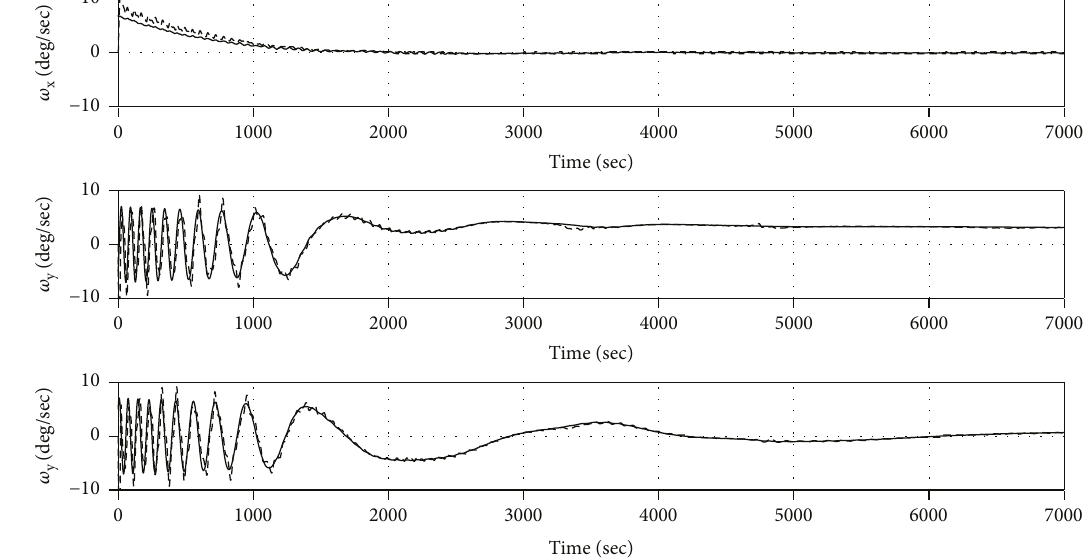
Figure 7: Actual and measured angular rates ( ω